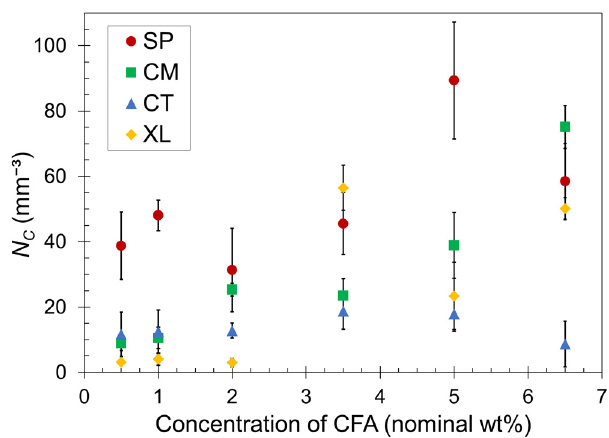
Figure 4. Calculated cell density versus CFA concentration for SP, CM, CT, and XL foams. The error bars indicate one standard deviation. The data points that do not show error bars have deviation ranges smaller than the point size.